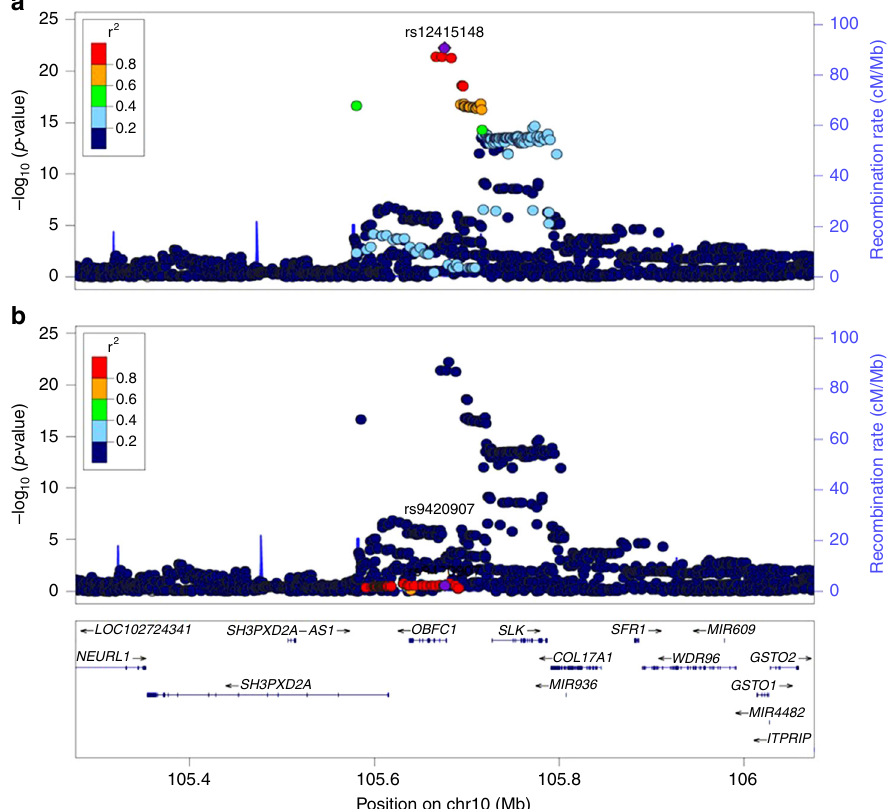
Fig. 2 Regional SNP associations at the OBFC1 gene locus in the SCHS discovery GWAS. a Association of lead SNP identi fi ed in the SCHS (rs12415148). b Association of previously identi fi ed index SNP from European GWAS studies (rs9420907). Lead SNP indicated as purple diamonds. LD ( r 2 ) data of SNPs based on ASN panels of 1000Genome database. Plots plotted using LocusZoom (http://csg.sph.umich.edu/locuszoom/) P between 5.31 × 10 − 5 and 9.30 × 10 − 6 , Table 1 and Supplementary strong LD in Europeans were available for evaluation (best proxy Fig. 4). The 2 other loci identi fi ed in the Singaporean Chinese SNP at the TINF2 locus in chromosome 14 was rs3742506, however GWAS were monomorphic (rs28365964) or rare (MAF < 1%, LD between rs3742506 and the rs41293836 lead SNP was weak, rs41293836) in the European populations and no proxy SNPs in r 2 = 0.35 in 1000G CEU panel). NATURE COMMUNICATIONS| (2019) 10:2491